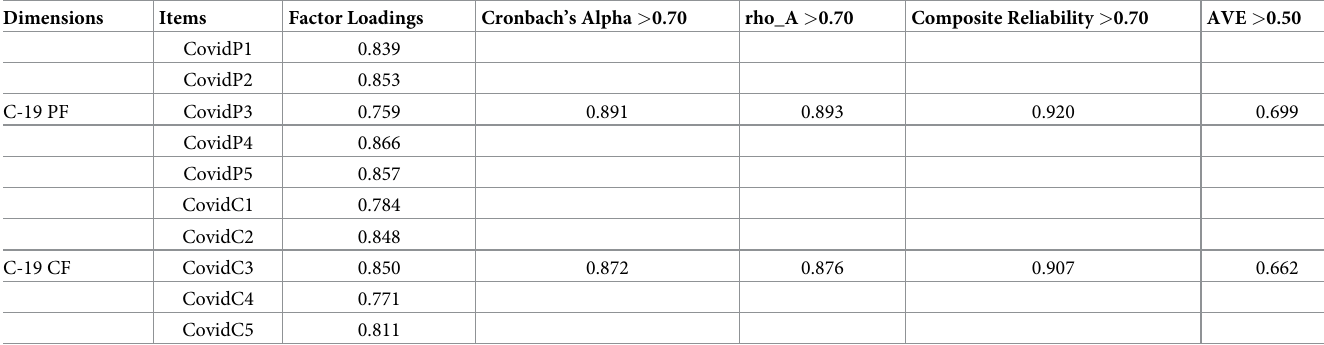
Table 3. First-order measurement model.